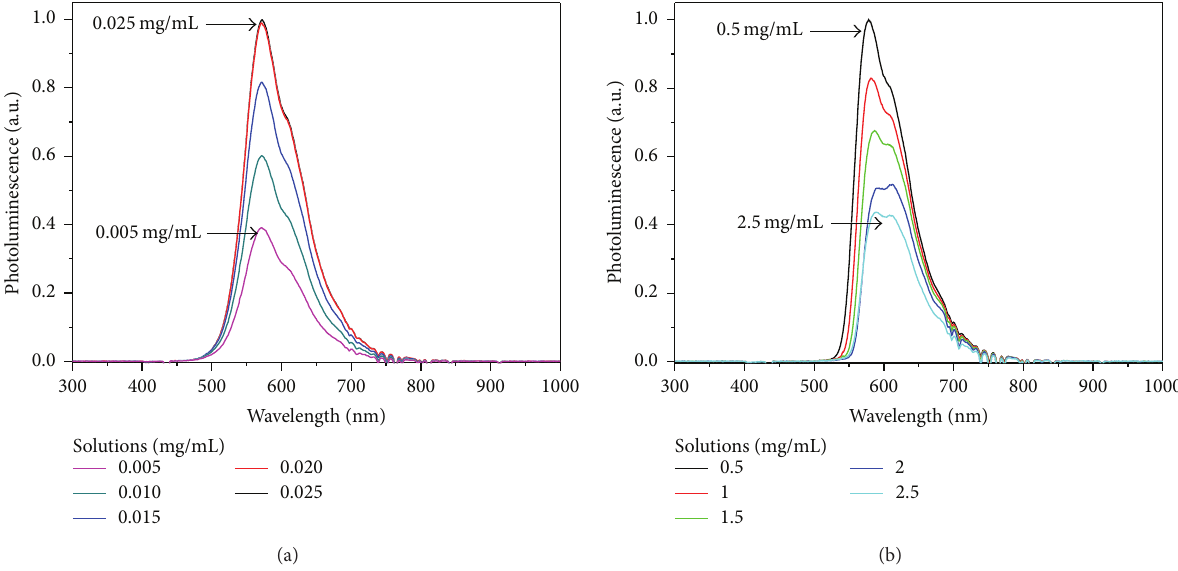
Figure 3: PL spectra of the copolymer P1, (a) diluted and (b) concentrated toluene solutions under UV excitation at 365 nm.